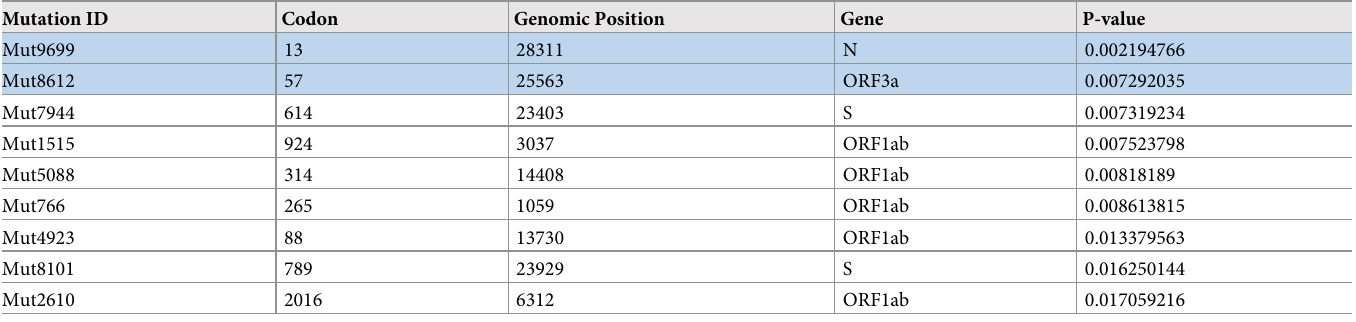
Two protein mutations of interest are and highlighted in light blue (see sections below for